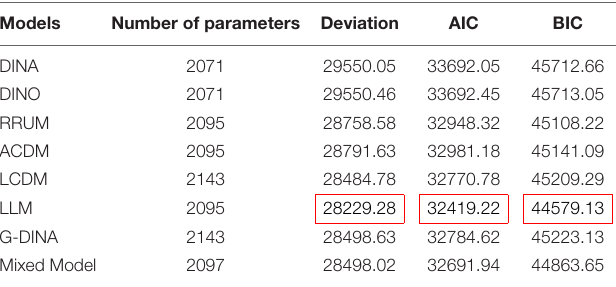
TABLE 3 | Parameter statistics comparison of different